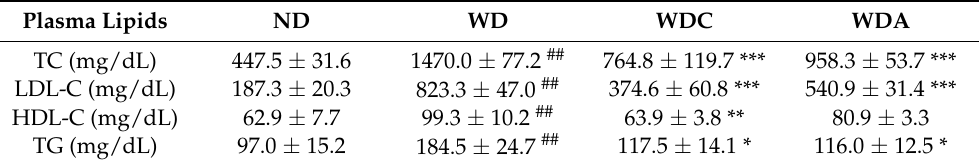
Table 1. Plasma lipid levels in ApoE − / − mice with normal and Western-type diets. Plasma Lipids ND WD WDC WDA TC (mg/dL) 447.5 ±